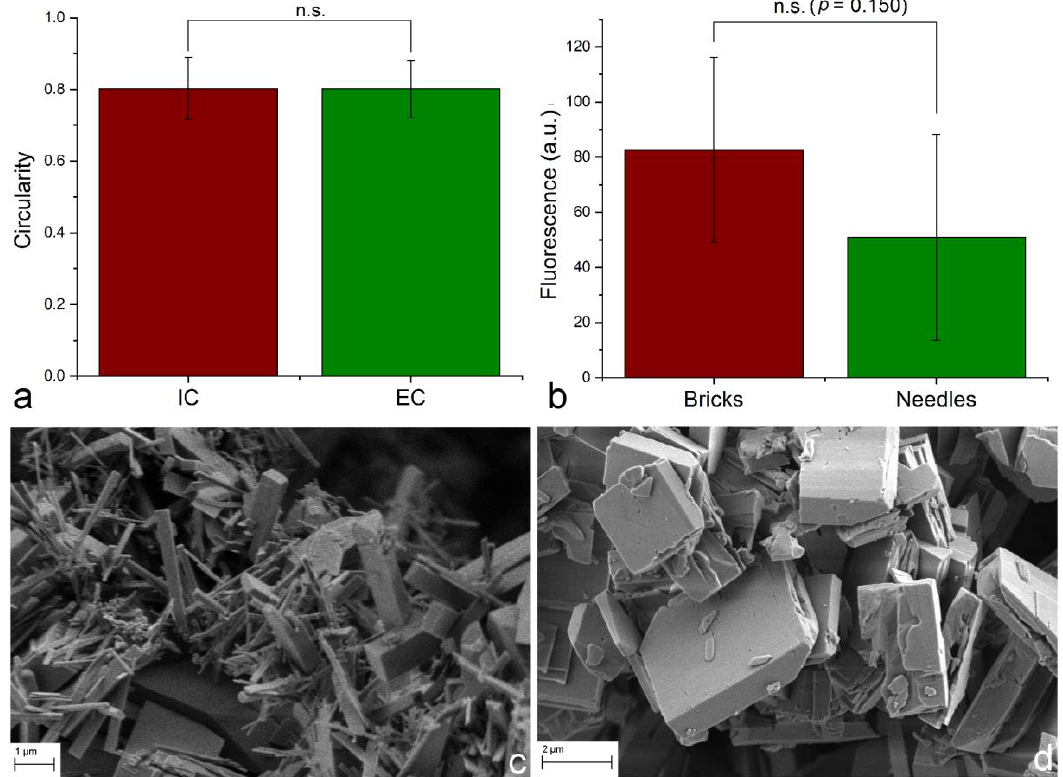
Figure 6. Identical circularities of HAp nanoparticle agglomerates localized intracellularly (IC) and extracellularly (EC) with respect to the hMSCs ( a ). Statistically insignificantly lower fluorescence originating from internalized needle-shaped HAp nanoparticles ( c ) compared to that of their brick-shaped counterparts ( d ), indicating that the uptake is morphologically dependent for samples composed of nanoparticles with unique morphologies ( b ), despite being morphologically independent with respect to geometries of agglomerates of nanoparticles in single samples. Data points in ( a ) and ( b ) represent averages, error bars represent standard deviation, and p -values represent the confidence intervals for the statistical significance of the difference between the sample groups.